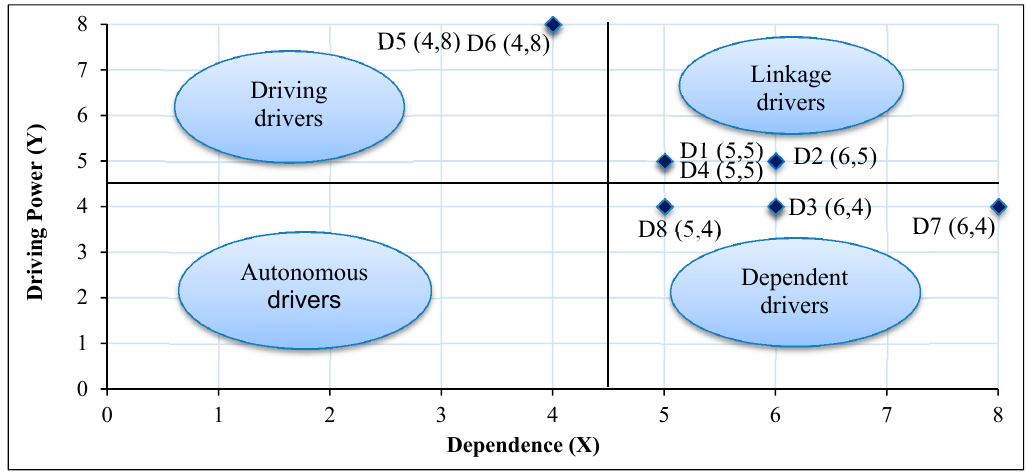
Table 7. Level matrix of the drivers of OSC. Drivers